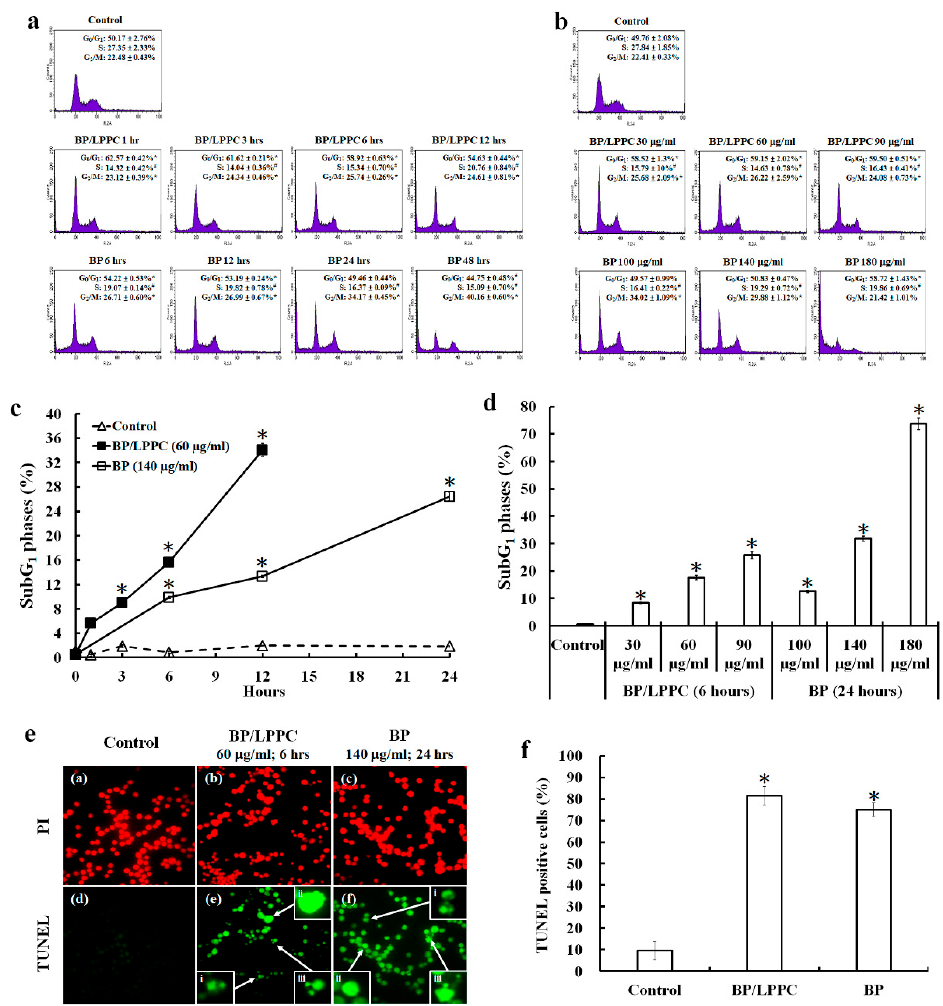
Figure 3. BP / LPPC induced cell cycle arrest and apoptosis in colorectal cancer cells. HT-29 cells were treated with BP / LPPC (30, 60 and 90 µ g / mL) for 0, 1, 3, 6 or 12 h or BP (100, 140 and 180 µ g / mL) for 0, 6, 12, 24 or 48 h. The treated cells were analyzed for the cell cycle distribution ( a , b ), percentage of SubG 1 ( c , d ) and TUNEL staining ( e ). Chromatin condensation (i), DNA fragmentation (ii) and apoptotic bodies (iii) were observed under a fluorescence microscope (400 × ). ( f ) Statistical analysis of TUNEL assay. The results are presented as the mean ± SD. * p < 0.05 compared with the control, with a significant increase. # p < 0.05 compared with the control, with a significant decrease.